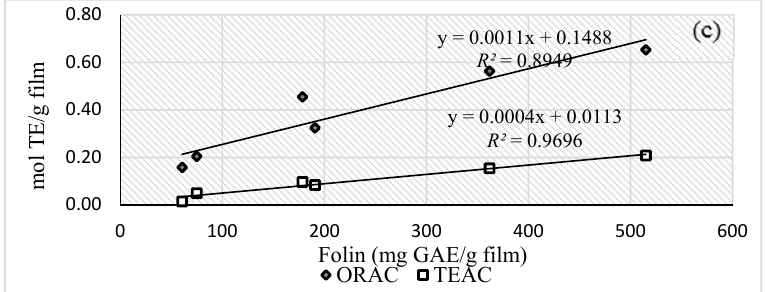
Figure 1. ( a ) Polyphenol concentration of films with different concentrations of plants extracts: Caesalpinia spinosa 1 (CS1) (0.07%), CS2 (0.1%), CS1 (0.2%), Caesalpinia decapetala 1 (CD1) (0.3%), CD2 (0.7%), CD1 (1%); ( b ) Antioxidant activity by oxygen radical absorbance capacity (ORAC) and Trolox